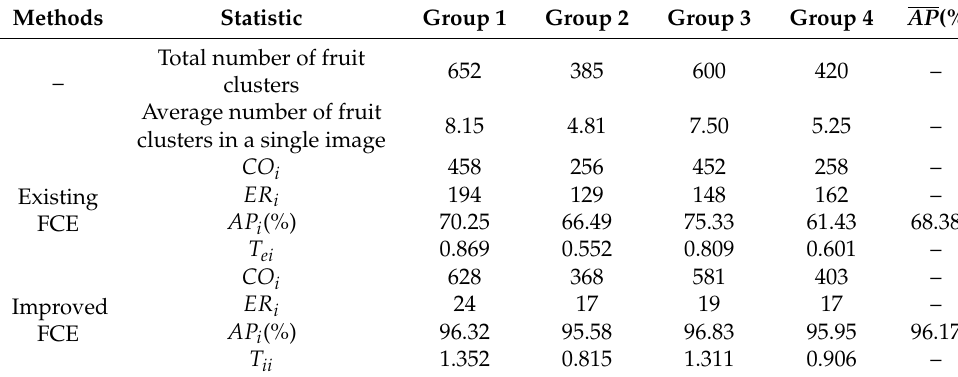
Table 6. Experimental results of grasping